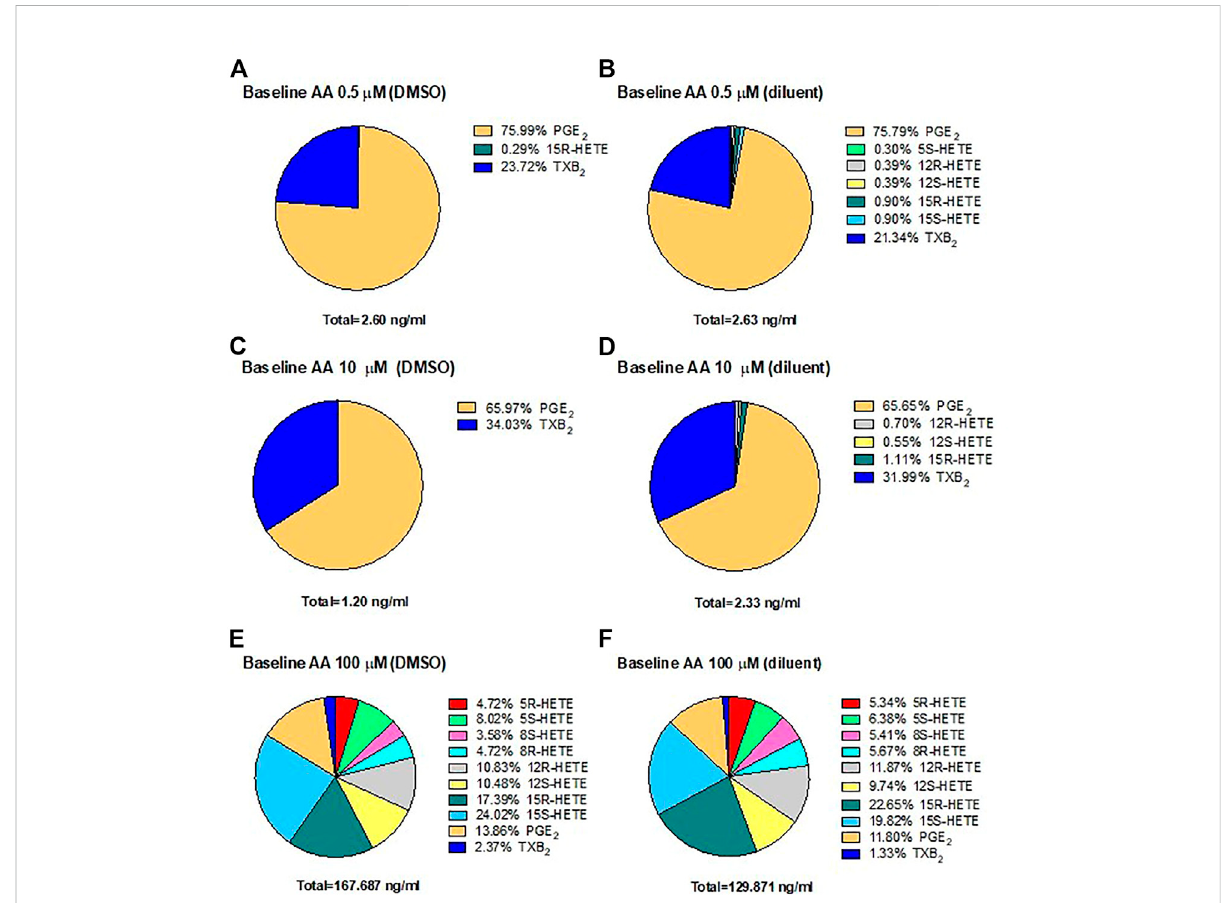
FIGURE 4 Biosynthesis of eicosanoids by human colon cancer HCA7 cells in response to physiological or high concentrations of exogenous AA in the presence of DMSO or diluent (triacetin and saccharin) by targeted chiral lipidomics analysis using LC-MS/MS. HCA7 cells (1 × 10 6 ) were treated with DMSO or diluent for 30 min, and then AA 0.5 (A,B) , 10 (C,D) , or 100 μ M (E,F) was added, and the incubation was continued for further 30 min; then, prostanoids and HETEs were assessed in the conditioned medium by LC-MS/MS. Pie charts reporting the generation of eicosanoids in cancer cells from 4 separate experiments; data are shown as the percentage of each eicosanoid versus the total concentration of all eicosanoids produced in the presence of DMSO (ASA vehicle) or diluent (triacetin, saccharin, constituents of